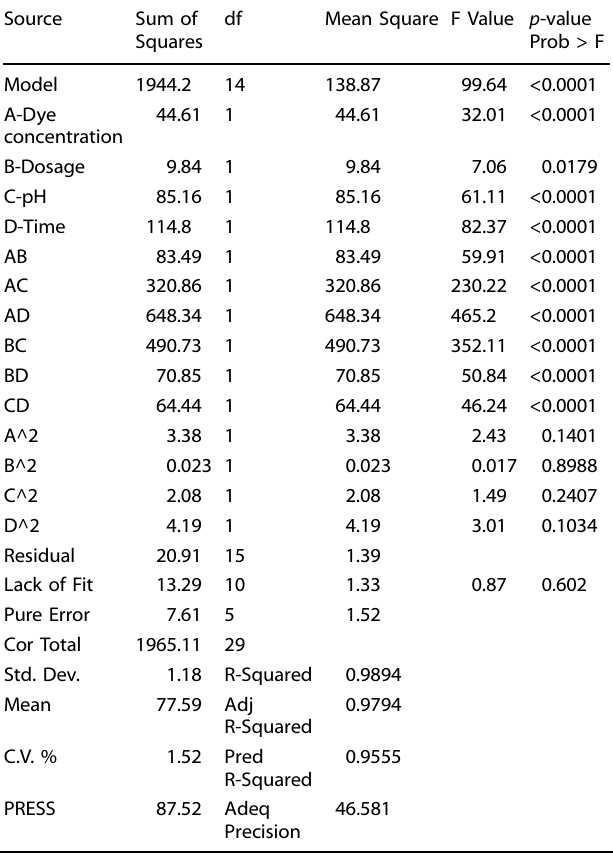
Table 1. Analysis of